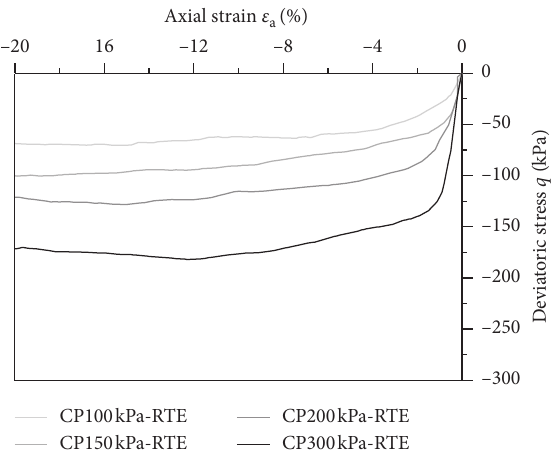
Figure 7: Undrained stress-strain relation of Delhi silt under the RTE stress